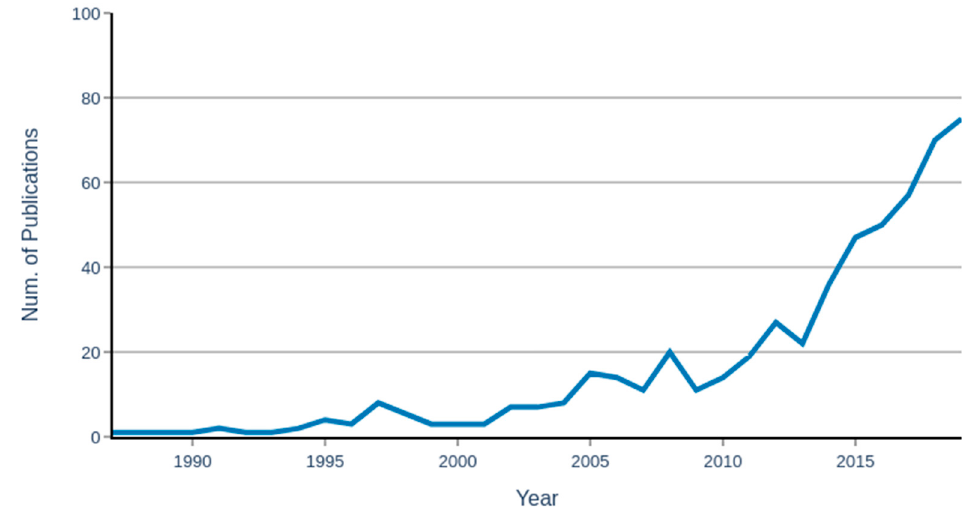
Figure 2. The number of publications demonstrating the use of AI in the OSH field from 1986 to 2019. The x -axis is the year of publication and the y -axis is the number of the AI papers published with an OSH application. All AI papers queried were individually reviewed to confirm the OSH